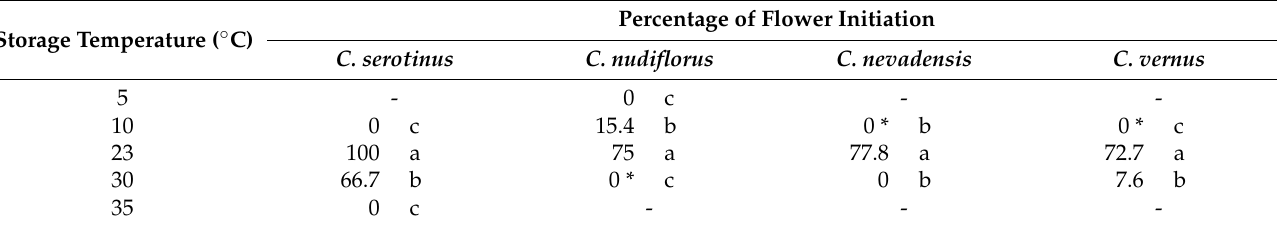
Table 3. Effect of the corm storage temperature on the flower primordia formation in the autumn- and spring-flowering crocus species. Corms were stored from mid-June to mid-September. Percentages of corms with flower primordia (microscopically observed) corresponding to the average values of two experiments carried out in consecutive years are presented. Thirty-five to 45 corms per treatment and species were observed each